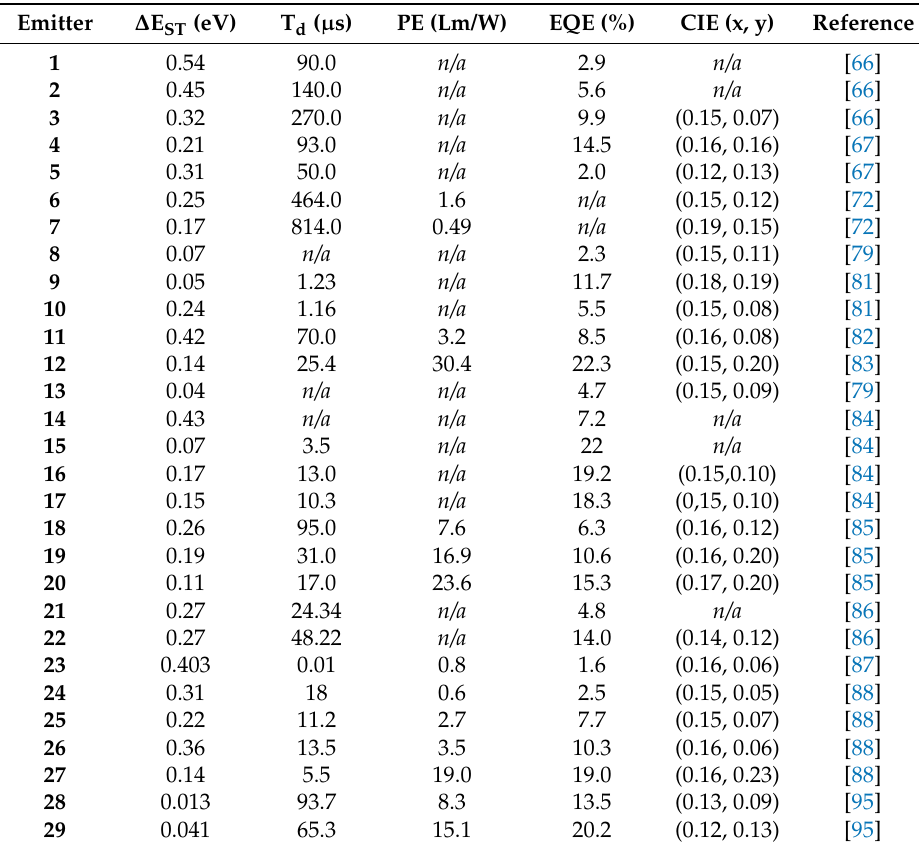
Table 1. TADF and OLED characteristics of deep blue